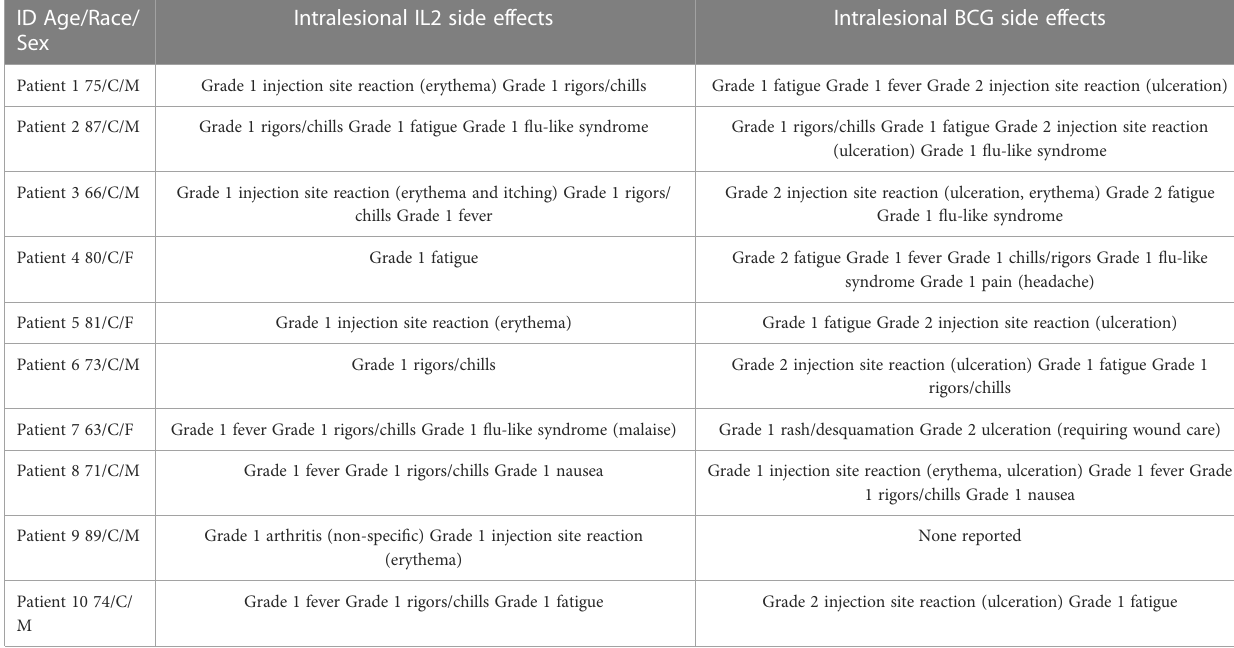
TABLE 2 Side effect pro fi le of iIL2 and intralesional BCG.